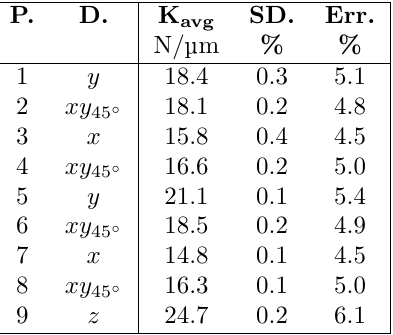
Table 7: 3-axis CNC, test 1.3: average stiffness at dif- ferent positions (P.) and directions (D.).